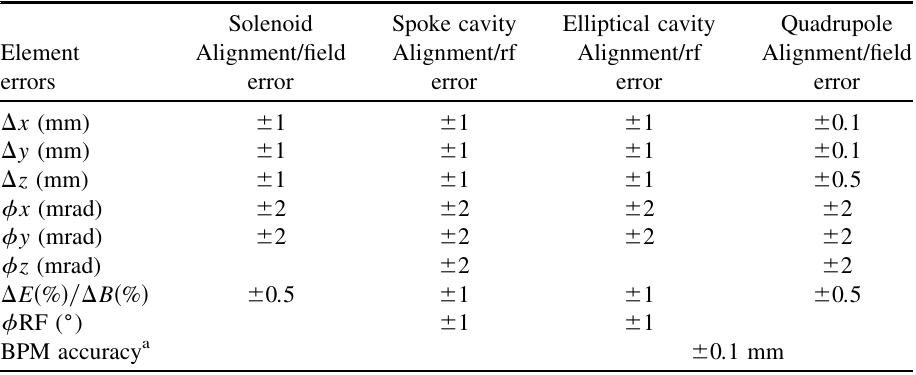
Solenoid Spoke cavity Elliptical cavity Quadrupole Element Alignment/field errors